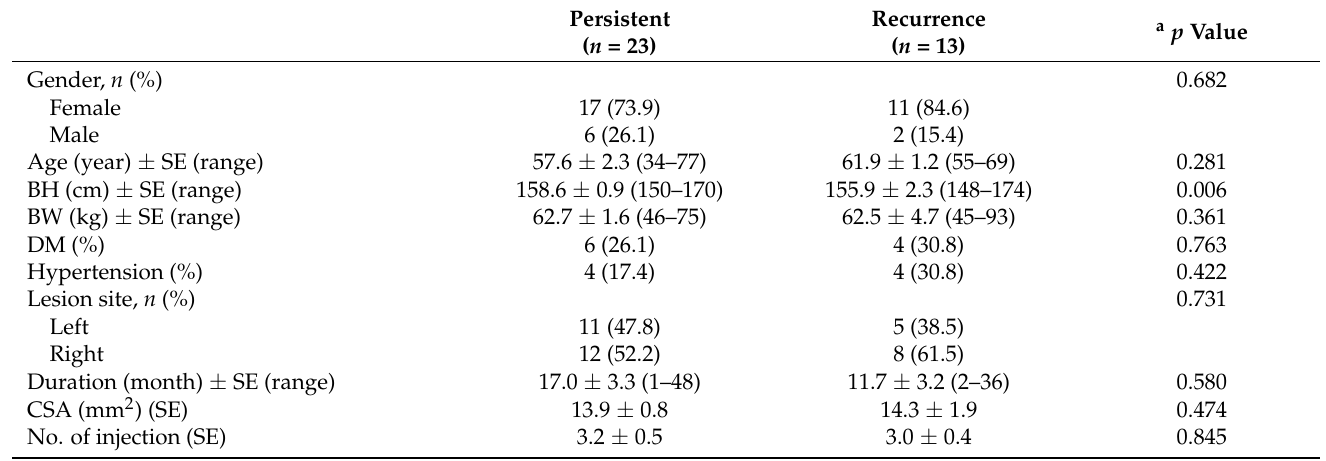
Table 2. Demographic information of persistent and recurrent